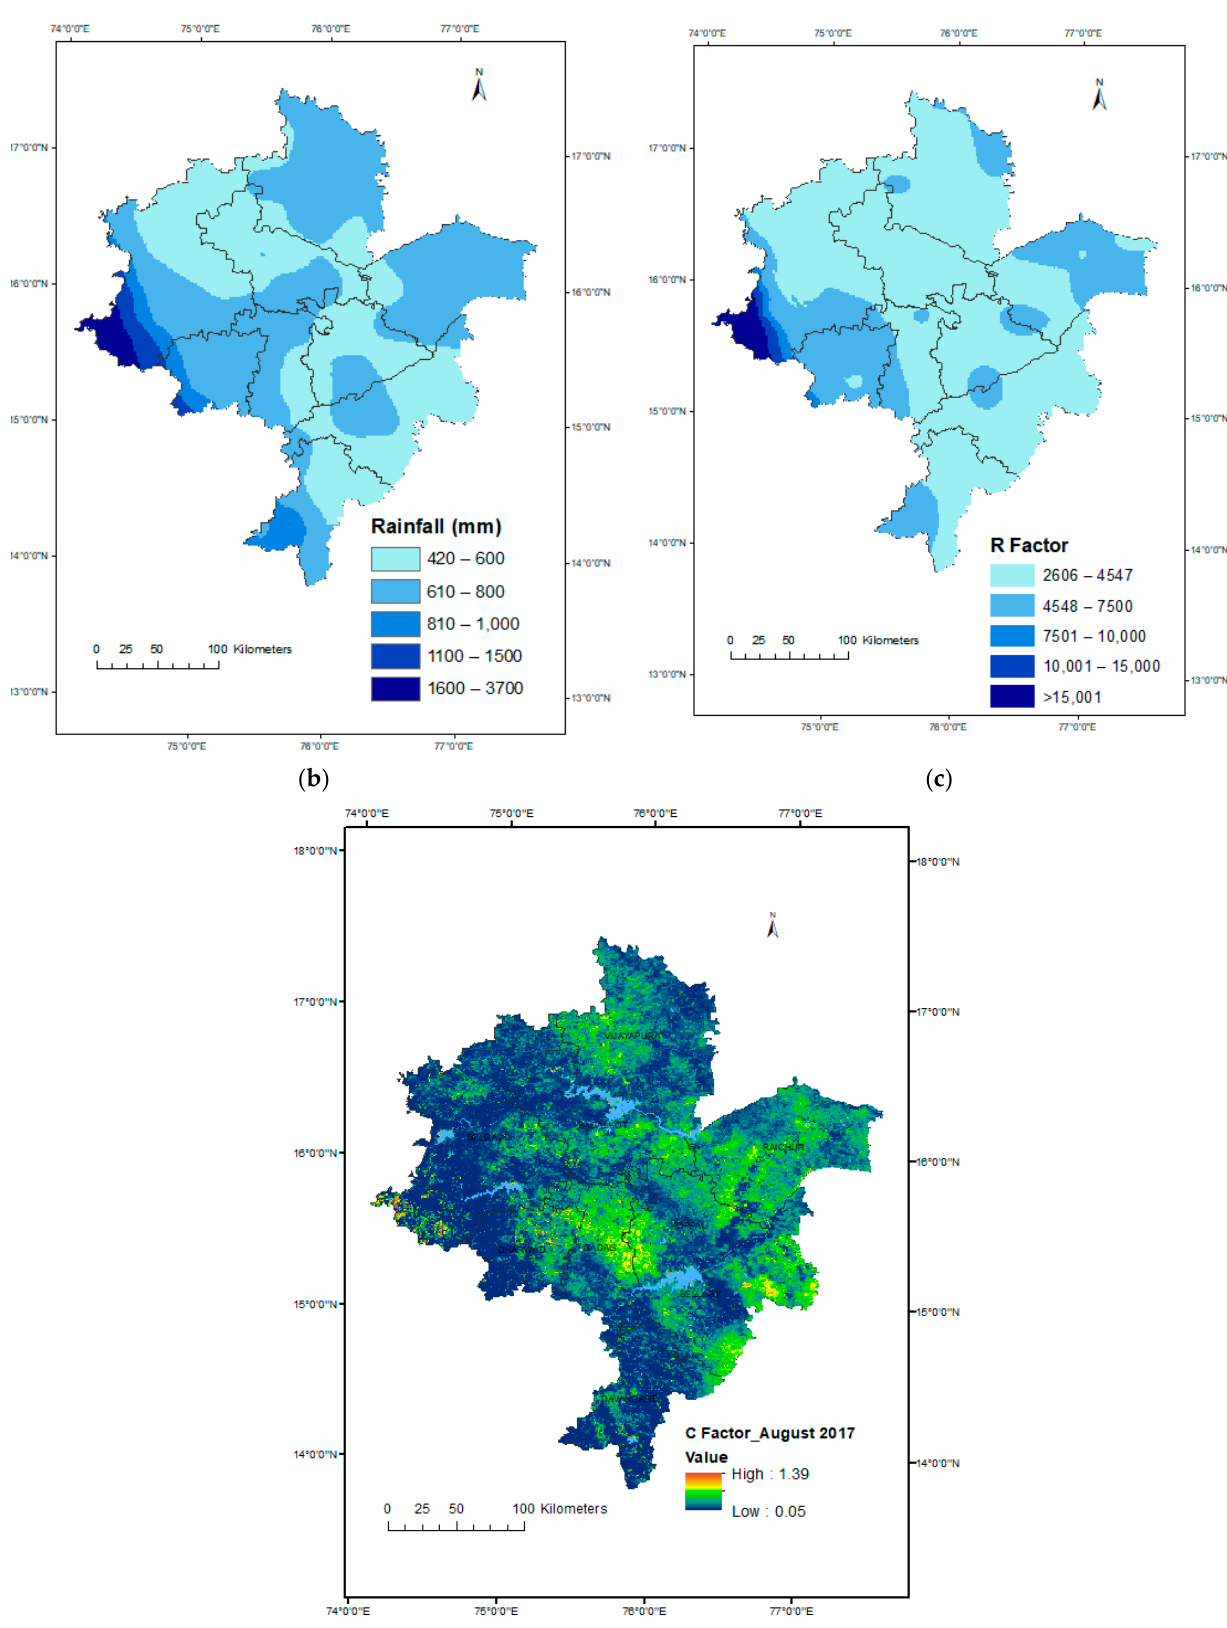
Figure 3. ( a ). Flow chart depicting the planning of soil and water conservation interventions. ( b , c ) Rainfall and erosivity ( R factor) in the study area. ( d ) C factor map for the selected area during August